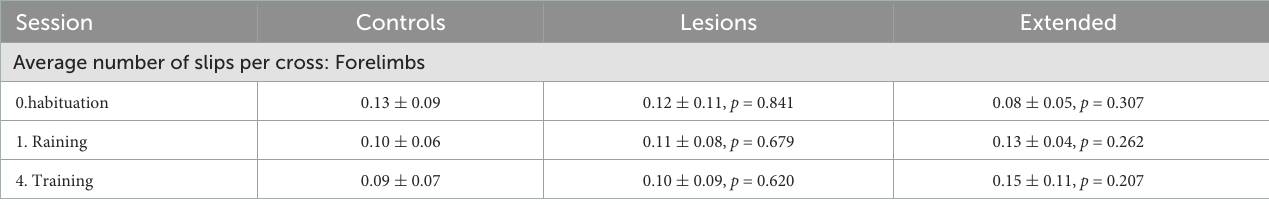
TABLE 4 Average number of forelimb slips per crossing of each group for sessions with stable obstacles (mean ± standard deviation, p -values report Student’s unpaired t -test against the control group). Session Controls Lesions Extended Average number of slips per cross: Forelimbs